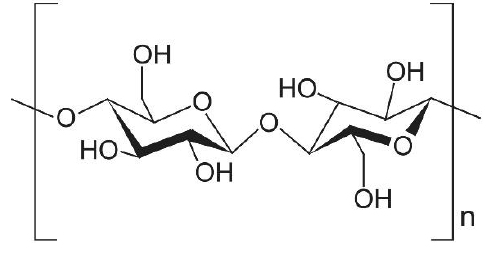
Figure 1. The repeating unit of cellulose.